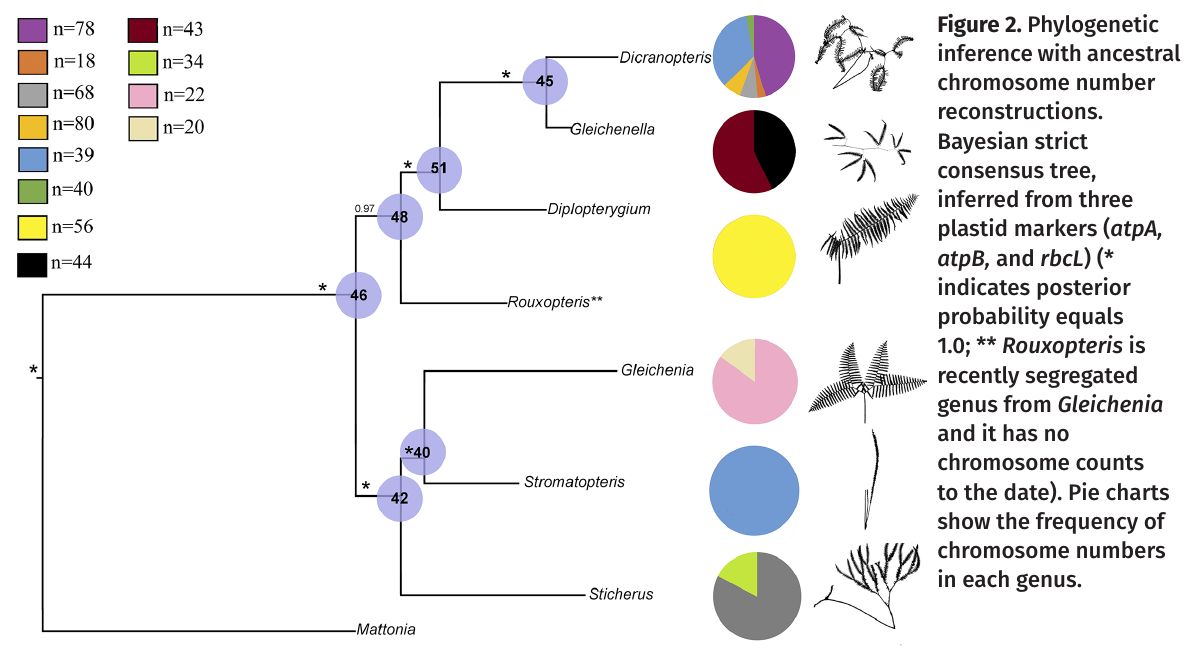
Figure 1. Distribution of chromosome numbers in the sampled species.